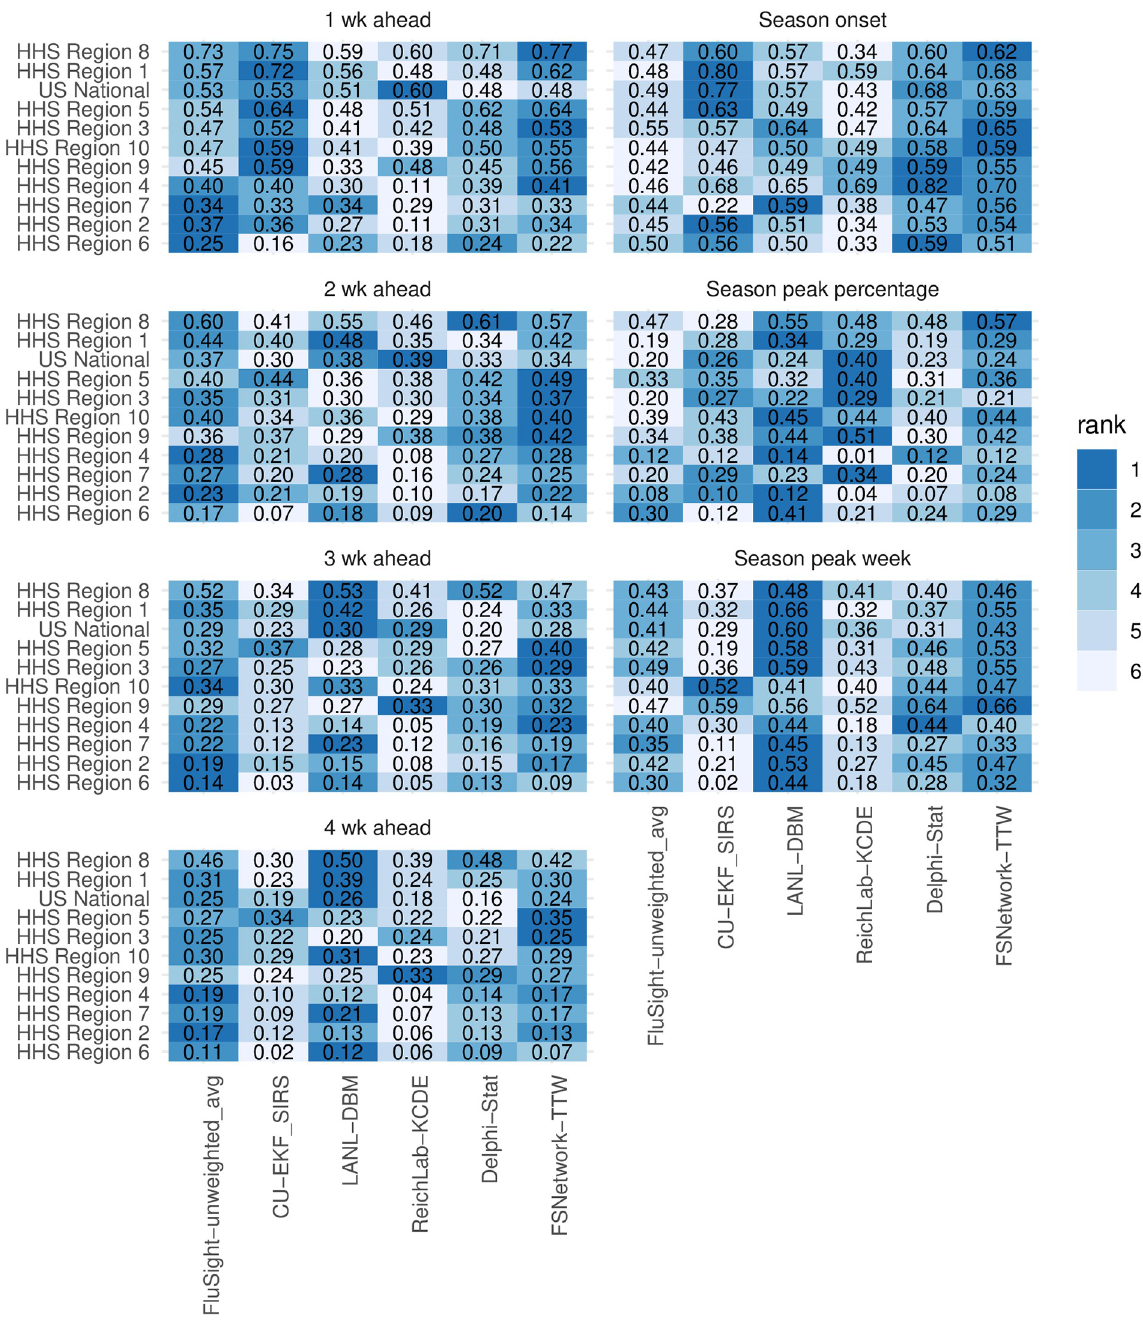
Fig 5. Average forecast scores and ranks by target and region for 2017/2018. Models shown include the FSNetwork-TTW model, the top performing model from each team during the training phase and the unweighted average of all FluSight models received by CDC. Color indicates model rank in the 2017/2018 season (darker colors indicates higher rank and more accurate forecasts) and the forecast score (rounded to two decimal places) is printed in each cell. Regions are sorted with the most predictable region overall (i.e. highest forecast scores) at the top.